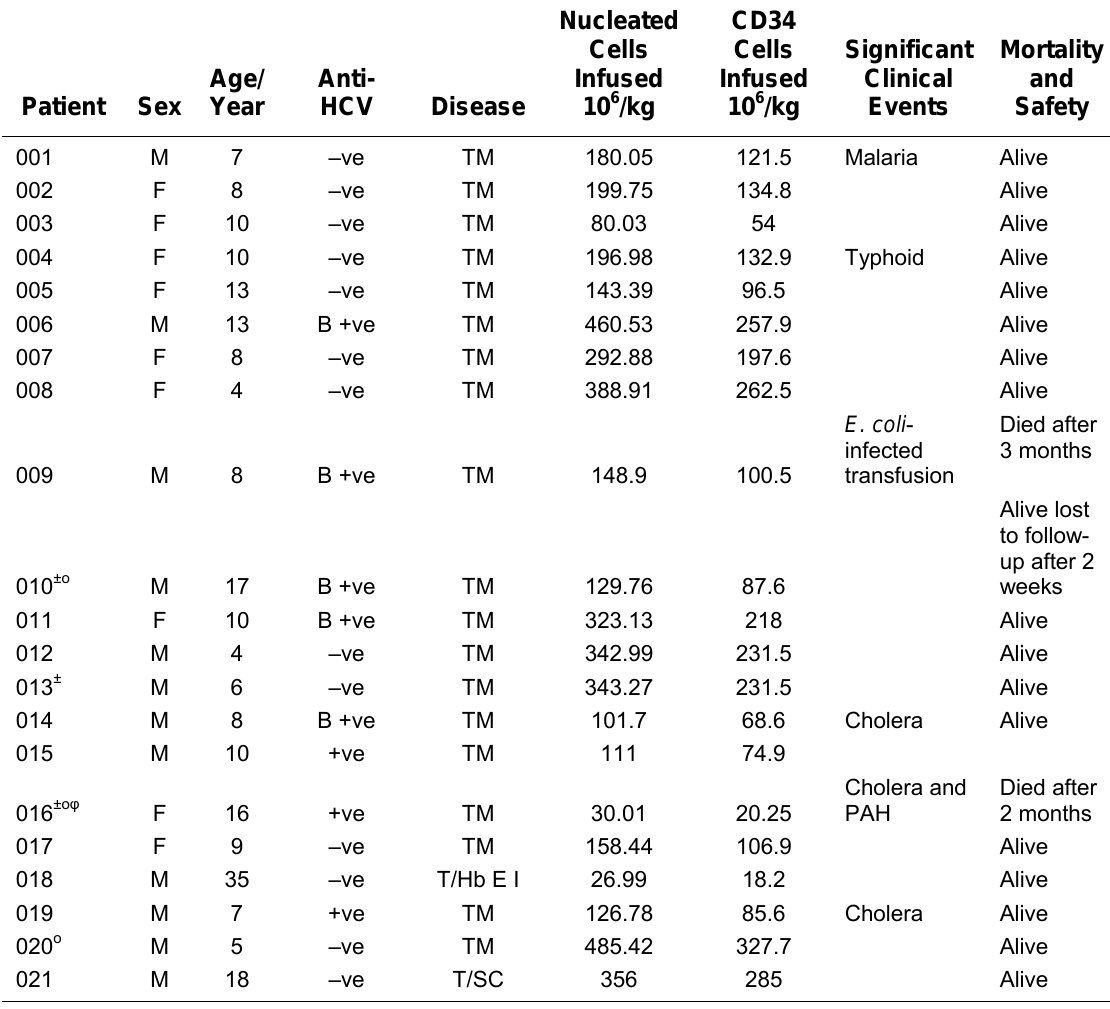
Clinical and RSC Infusion Details as well as Outcome of Patients with Beta-Thalassemia